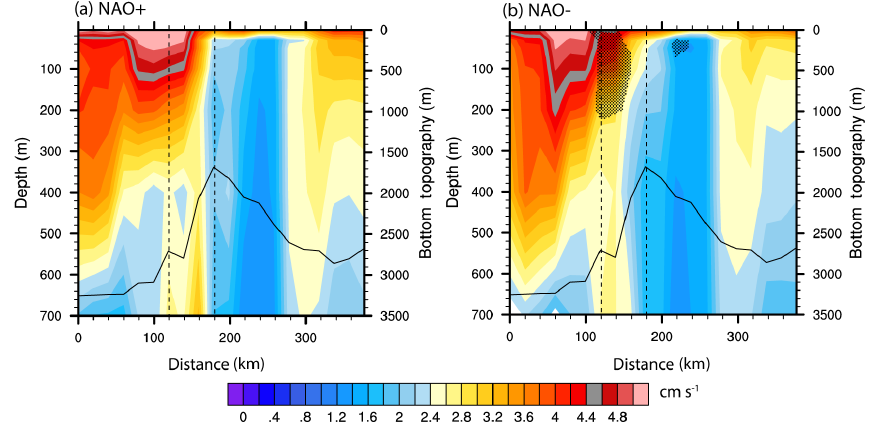
Figure 10. Composite of currents speed (cms − 1 ) along the hydrographic section across the Mohn Ridge during (a) NAO + and (b) NAO − . The dashed vertical lines show the position of the core of the AF. Black stripped region in panel (b) indicates the region where the composite mean speed is significantly different from the climatological mean speed at 10% significance